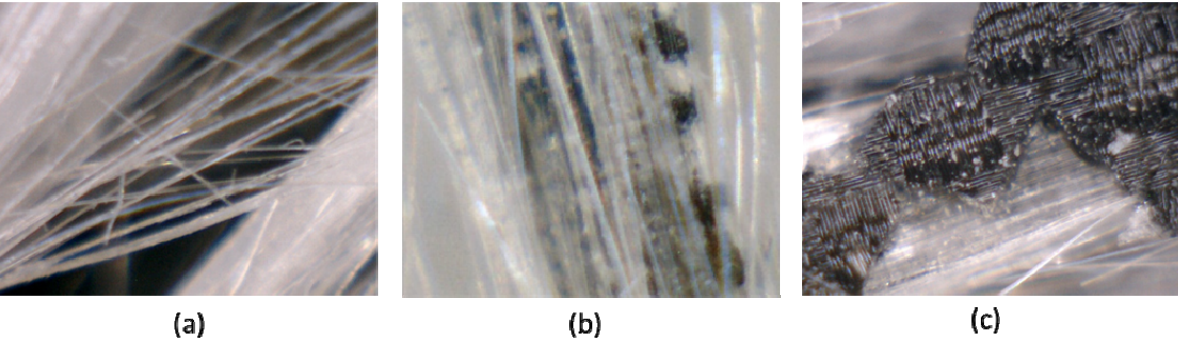
Figure 8. One-hundred-times-magnified microscopic imaging on the failure region in GFRP composites incorporating ( a ) 0 wt% (neat); ( b ) 0.5 wt%; and ( c ) 1.0 wt%